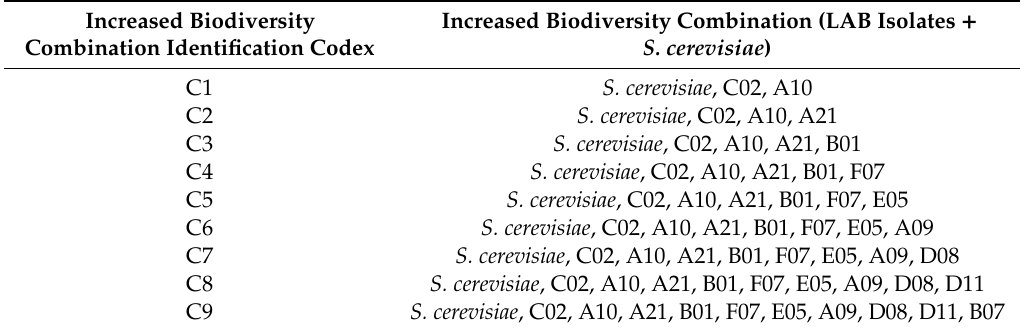
Table 4. Increased biodiversity combination of the S. cerevisiae strain and LAB isolates for the sourdough